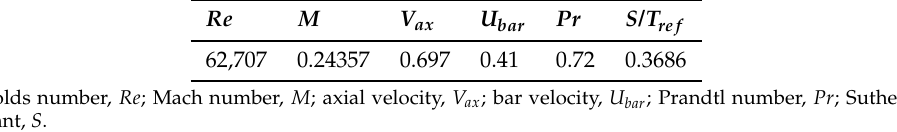
Table 1. Inlet parameters for the cascade